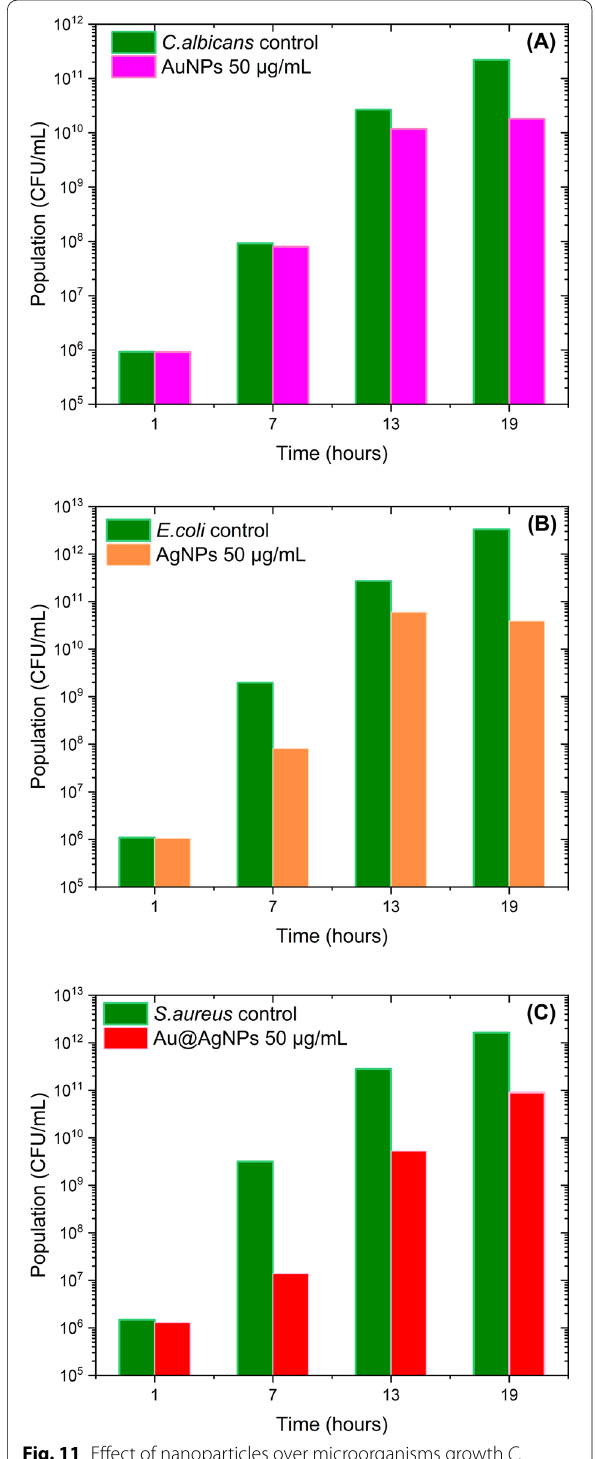
Fig. 11 Effect of nanoparticles over microorganisms growth C. albicans exposed to AuNPs ( a ), E. coli exposed to AgNPs ( b ), and S. aureus exposed to Au@AgNPs ( c ). All microorganisms were exposed at 50 µg/mL nanoparticles